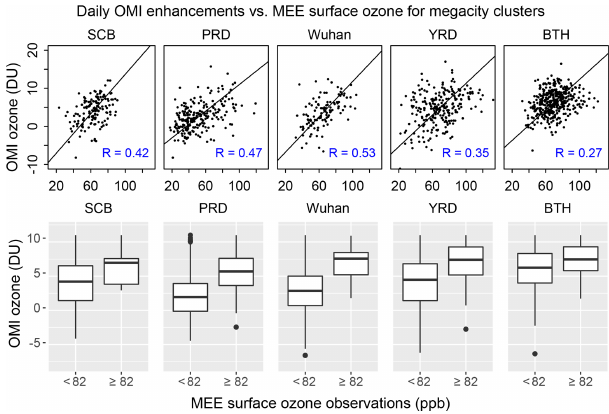
Figure 2. Ability of daily OMI observations to detect high-ozone episodes in the five megacity clusters of Fig. 1. Daily surface after- noon (12:00–15:00 local time) observations from the MEE network in summer (JJA) 2013–2017 averaged over the megacity clusters are compared to the corresponding OMI enhancements relative to the Pacific background. The top panels show the correlations in the daily data, with correlation coefficients inset. Reduced-major-axis (RMA) linear regression lines are also shown. The bottom panels show the distributions of OMI enhancements for episode ( ≥ 82ppb) and non-episode ( < 82ppbv) days. The top and bottom of each box are the 25th and 75th percentiles, the centerline is the median, the vertical bars are the 2nd and 98th percentiles, and the dots are out-